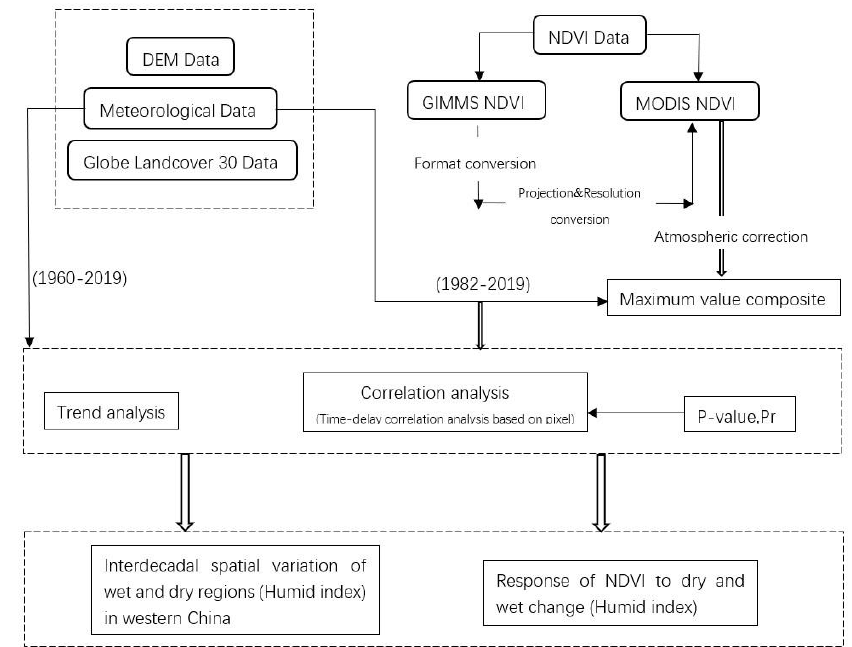
Figure 2. Flowchart of the study.